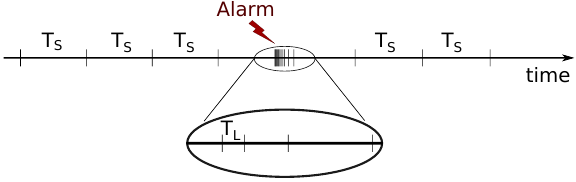
Figure 2. Example of sporadic behavior of GOOSE